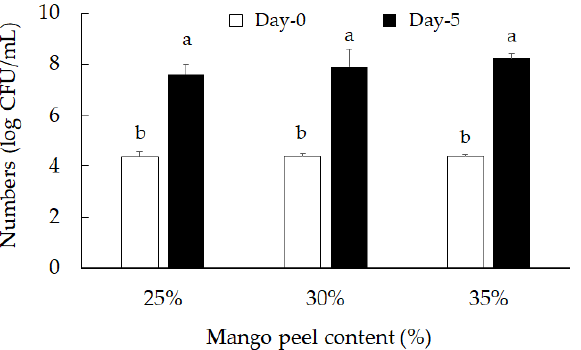
Figure 3. The change of bacterial number of L. acidophilus (BCRC14079)-fermented mango peel (various rations). Data are shown as means ± SD ( n = 3). Significant differences are shown by various letters ( p < 0.05).